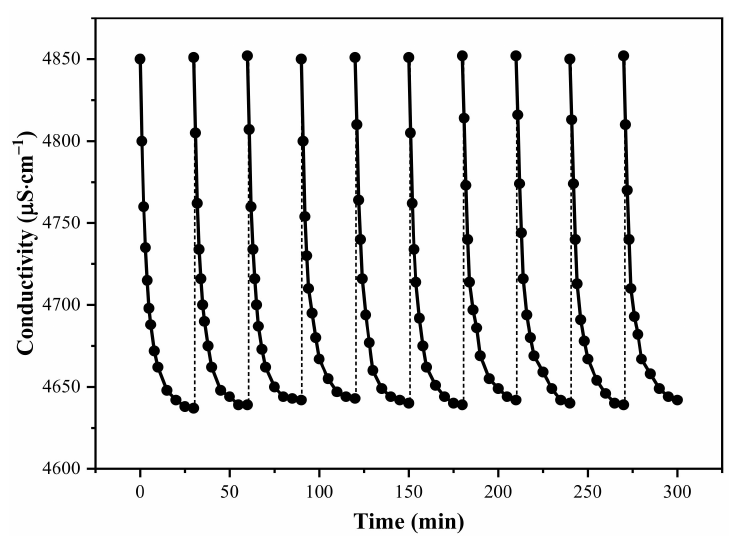
Figure 7. Cycling stability of